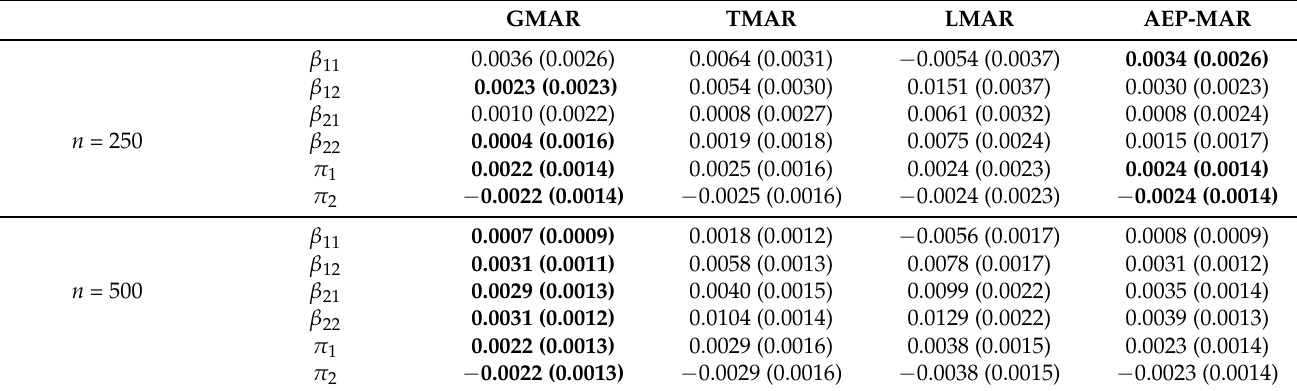
Table 1. Simulation results for Scenario 1 .